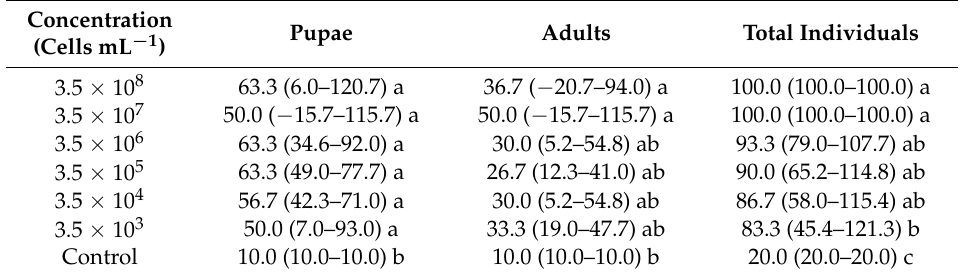
Table 5. Mortality of Drosophila suzukii pupae and adults, 9 days after spraying the pupae with Photorhabdus luminescens at different